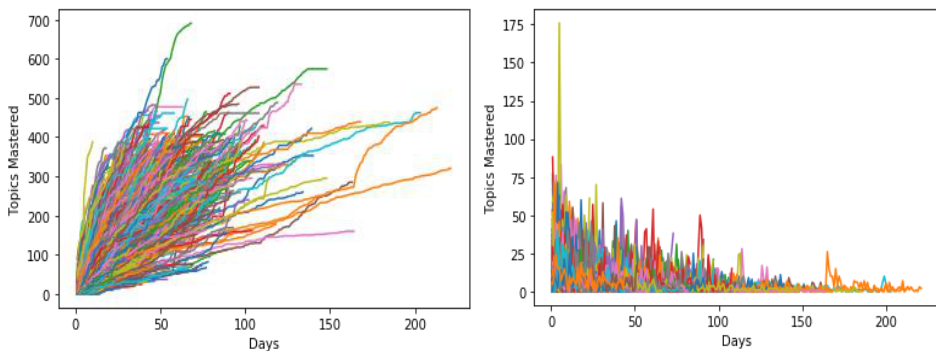
Figure 2. The cumulative rate of learning progression of each student ( left ). The rate of changes in learning progression of each student ( right ).